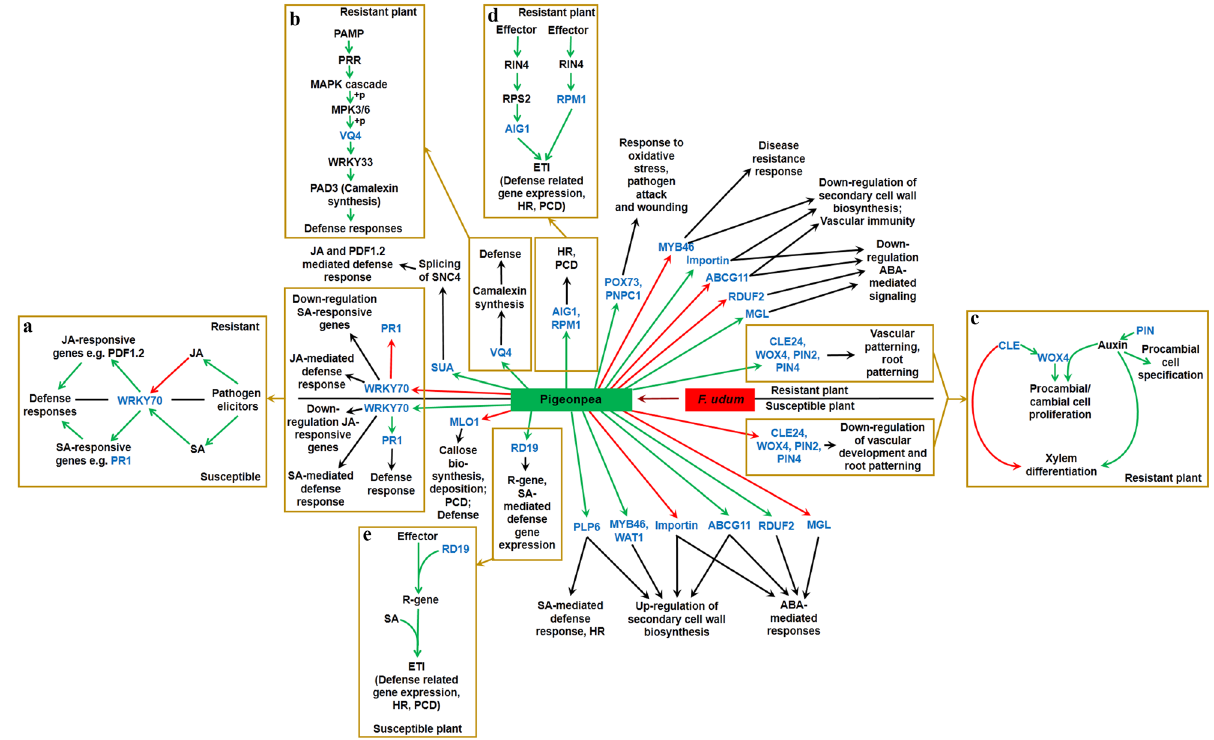
Figure 7. Overview of probable roles of differentially regulated TDFs during Fusarium wilt of pigeonpea. Green arrow: up-regulation; red arrow: down-regulation; black arrow: possible outcome due to up- or down- regulation of genes; golden arrow: elaborated pathway; blue font: genes differentially regulated in cDNA-AFLP; black font: other molecular factors with probable involvement, probable outcome of pathways. Inset ( a ): WRKY70-mediated cross-talk between Salicylic acid (SA)- and Jasmonic acid (JA)-dependent defense signaling 42 ; Inset ( b ): role of VQ4 during defense signaling against pathogen 46 ; Inset ( c , d ): regulation of RD19 ( c 70 ), AIG1 and RPM1 ( d 67,69 ) related to effector triggered immunity (ETI); Inset ( e ): Regulation of genes related to vascular development 48 . WRKY70 WRKY transcription factor 70, PR1 pathogenesis-related protein 1, PDF1.2 plant defensin 1.2, SUA SUPPRESSOR OF ABI3-5, SNC4 SUPPRESSOR OF NPR1-1, CONSTITUTIVE4, VQ4 VQ motif-containing protein 4, PAMP pathogen-associated molecular pattern, PRR pattern recognition receptors, WRKY33 WRKY transcription factor 33, PAD3 phytoalexin deficient 3, RPS2 resistance to Pseudomonas syringae protein 2, RIN4 RPM1-interacting protein 4, AIG1 avrRpt2 induced